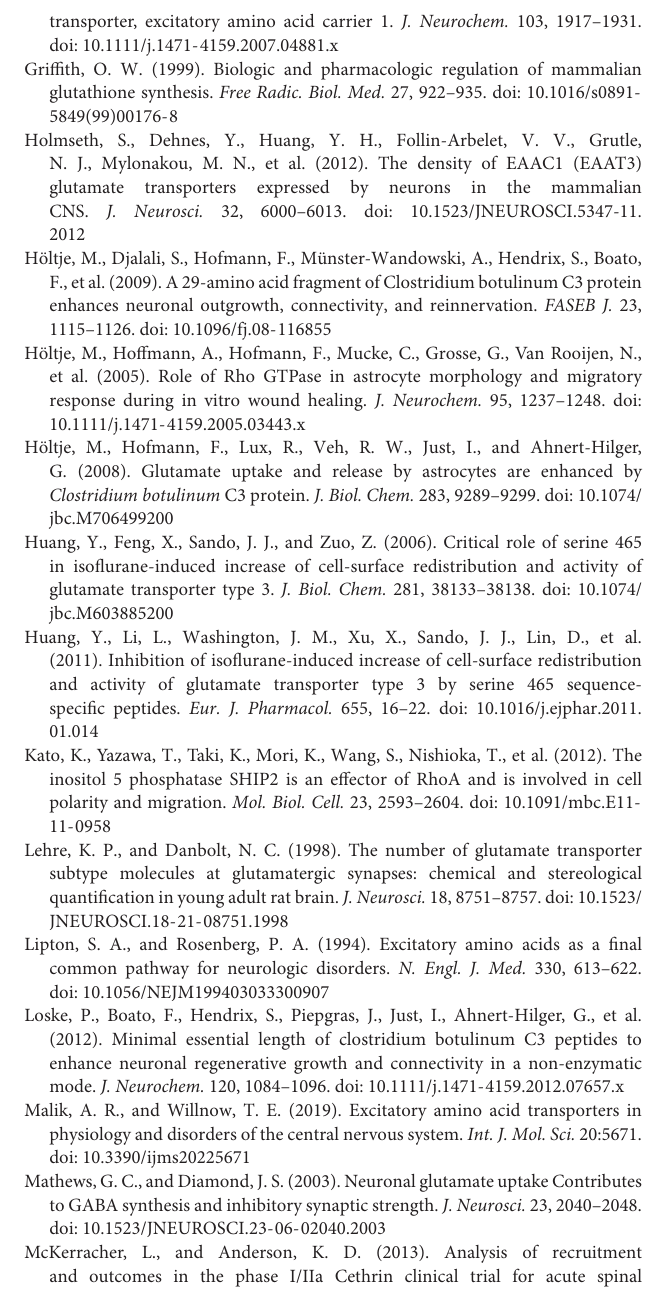
Supplementary Figure 2 | Hippocampal neurons grown for 14 days in culture were incubated with either 300 nM of C3bot or C3bot 26mer (3 days) or 200 nM of PMA for 20 min. Cells were fixed and stained against classic protein kinase C gamma (PKC γ ), novel protein kinase C epsilon (PKC ε ), and unconventional protein kinase C zeta (PKC ζ ). Readout of activation of PKCs was a shift to the plasma membrane. Under control conditions, neurons showed a mainly